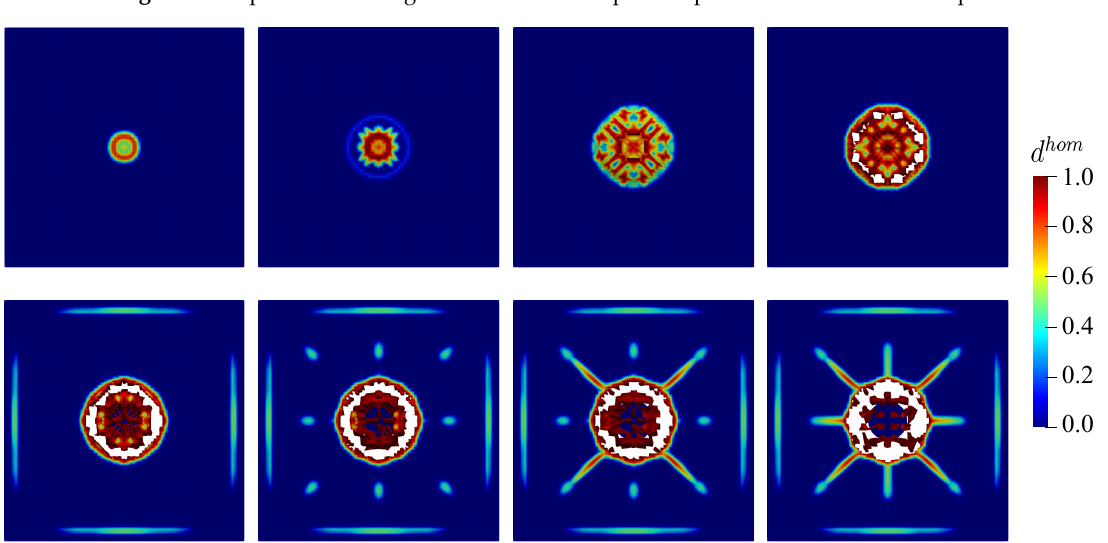
Figure 23. Bottom view of damage evolution for thin plate impact test at chosen time